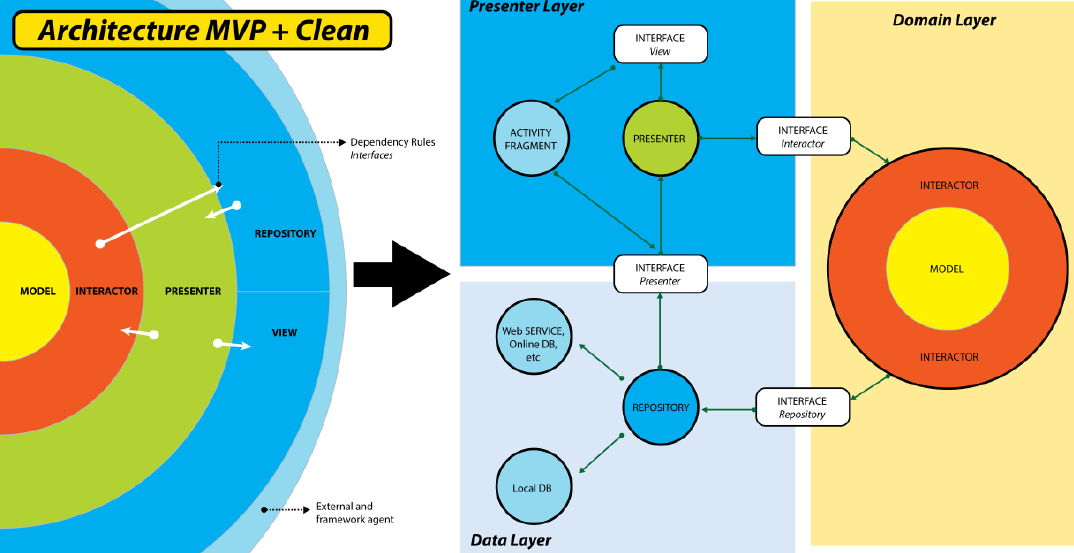
Figure 11. Model-View-Presenter (MVP) architecture + Clean.